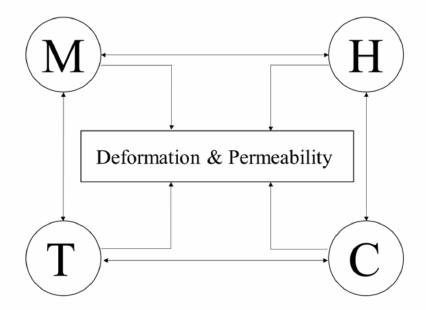
Figure 1. Interaction between TMHC fields and influence on deformation–permeability (TMHC;